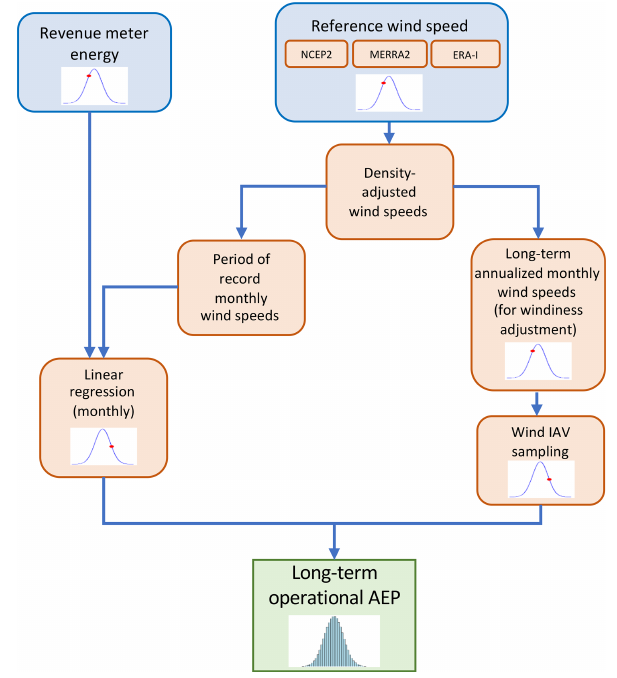
Figure 3. Long-term AEP estimation process using operational data under a Monte Carlo approach; sources of uncertainty and points of Monte Carlo sampling are denoted by probability distri- bution images. Note that IAV denotes interannual